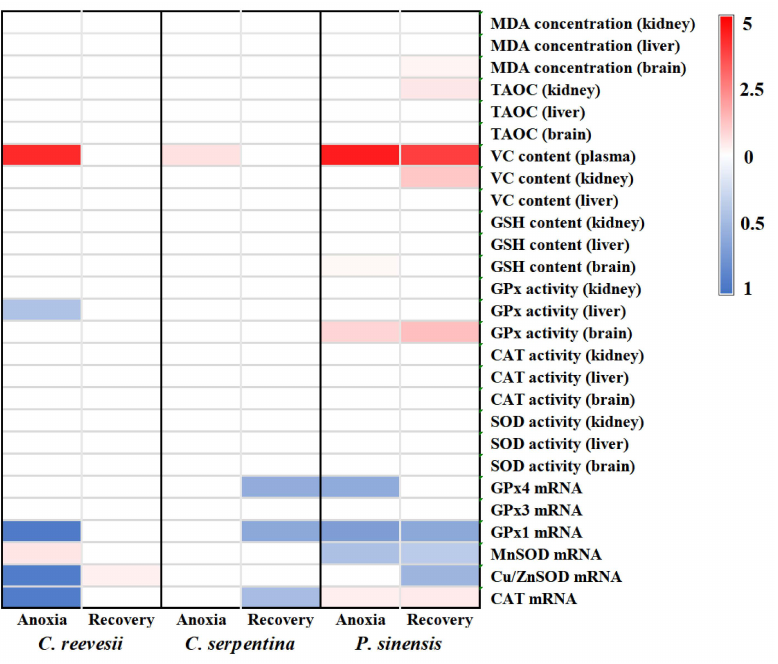
Figure 12. Sketch showing the changing pattern of different parameters in the three turtle